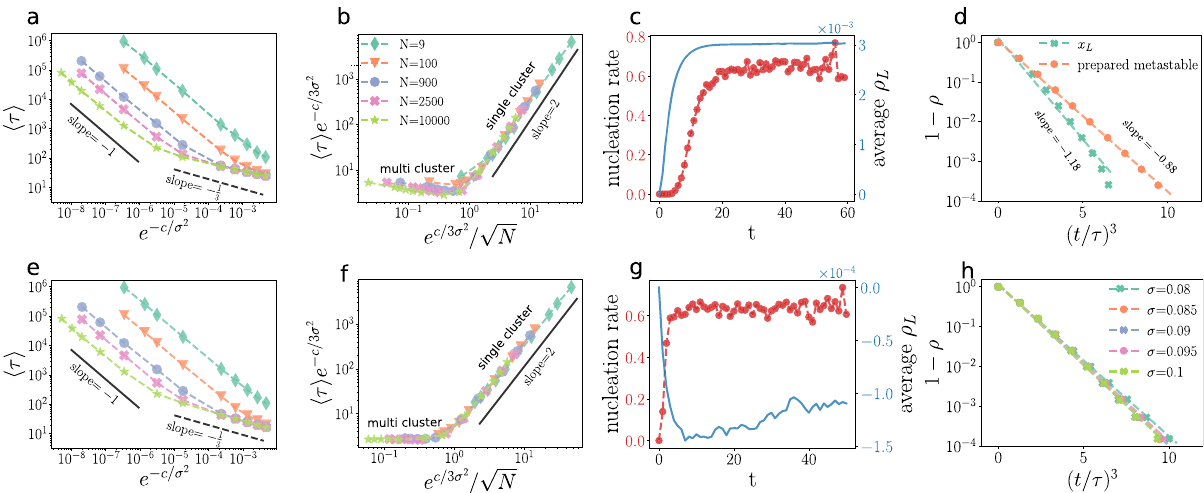
Fig. 5 Scaling between two cluster modes in the mutualistic system. For a – c , the system starts from the low state x L , and the time to reach the high state is characterized by τ . a The relationship of 〈 τ 〉 and e (cid:2) c σ 2 differs between two cluster modes, where c is a constant speci fi c to the dynamics and σ is the standard . For c and d , the deviation of noise. a , b , e , and f share the same legend. b The fi nite-size scaling is drawn by assuming the slope of multi-cluster mode in a is (cid:2) 1 3 system size is set as N = 10,000 and the noise strength is σ = 0.08. c The nucleation rate increases before the average low-state nodes stabilizes. d The system starts to evolve from x L and the prepared state, respectively. The single dots are simulation data, and different types of lines are obtained by linear fi t according q between the fi tted state to Eq. (9). The related uncertainty can be calculated by the standard deviation std ¼ and the simulated state, where n is the number of data for the linear fi t. The uncertainties are 0.42 and 0.09 for the initial state being x L and the prepared state, respectively. With the slope being fi tted, the global state evolution for the latter case agrees better with Eq. (9) than the former case. For e – h , the system starts from the prepared metastable state, and the time to reach the state x H is recorded as τ . e The average lifetime 〈 τ 〉 for two cluster modes. f The fi nite-size scaling is consistent with the theoretical prediction in Eq. (17). g The nucleation rate takes less time to stabilize compared with c . h The evolution of the global state ρ for the multi-cluster mode when N = 10,000 and σ = 0.08,0.085,0.09,0.095,0.1. The uncertainties of linear fi t are std = 0.09,0.14,0.13,0.13,0.15, 〈 τ 〉 of three diffusion models displays two distinct regimes. One is the single-cluster and the other is the multi-cluster regime (Fig. 7a, d, g). The slope of ln h τ i versus σ − 2 reveals which mode is active. If the system starts from the undesired stable state, the